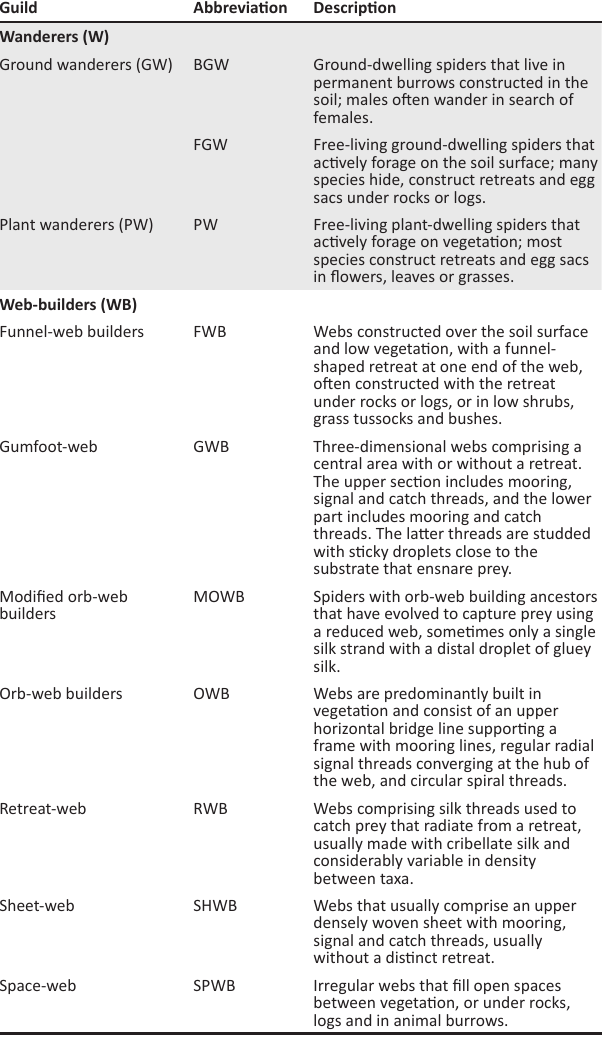
TABLE 2: Detailed descriptions of foraging guilds that were assigned to spider species sampled in the Tswalu Kalahari Reserve. Guild